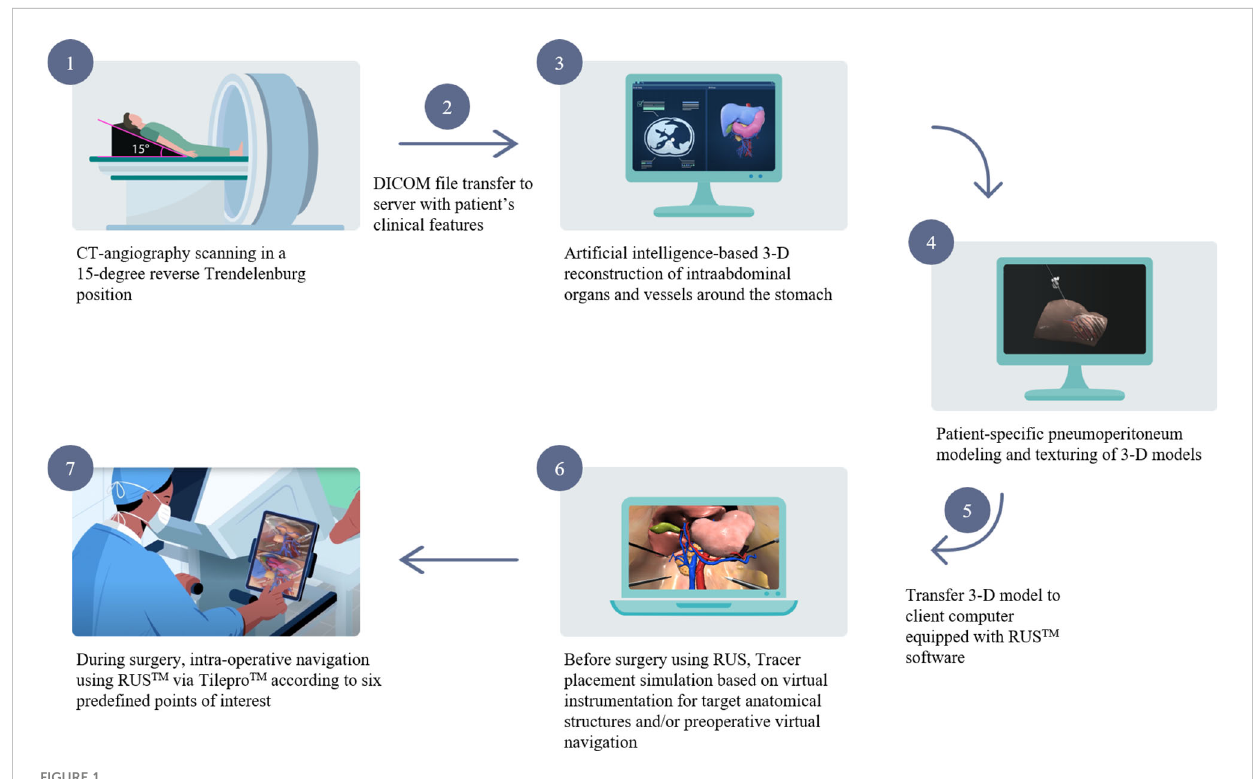
FIGURE 1 Schema of the patient-speci fi c virtual 3-D surgical navigation